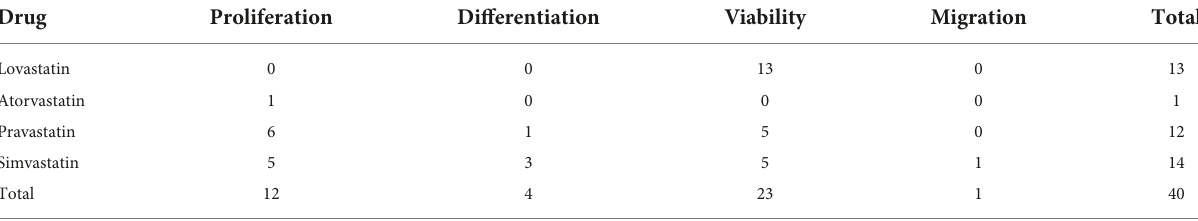
TABLE 2 Overview of experiments investigating statin effects on neural stem cell (NSC) characteristics. Drug Proliferation Differentiation Viability Migration